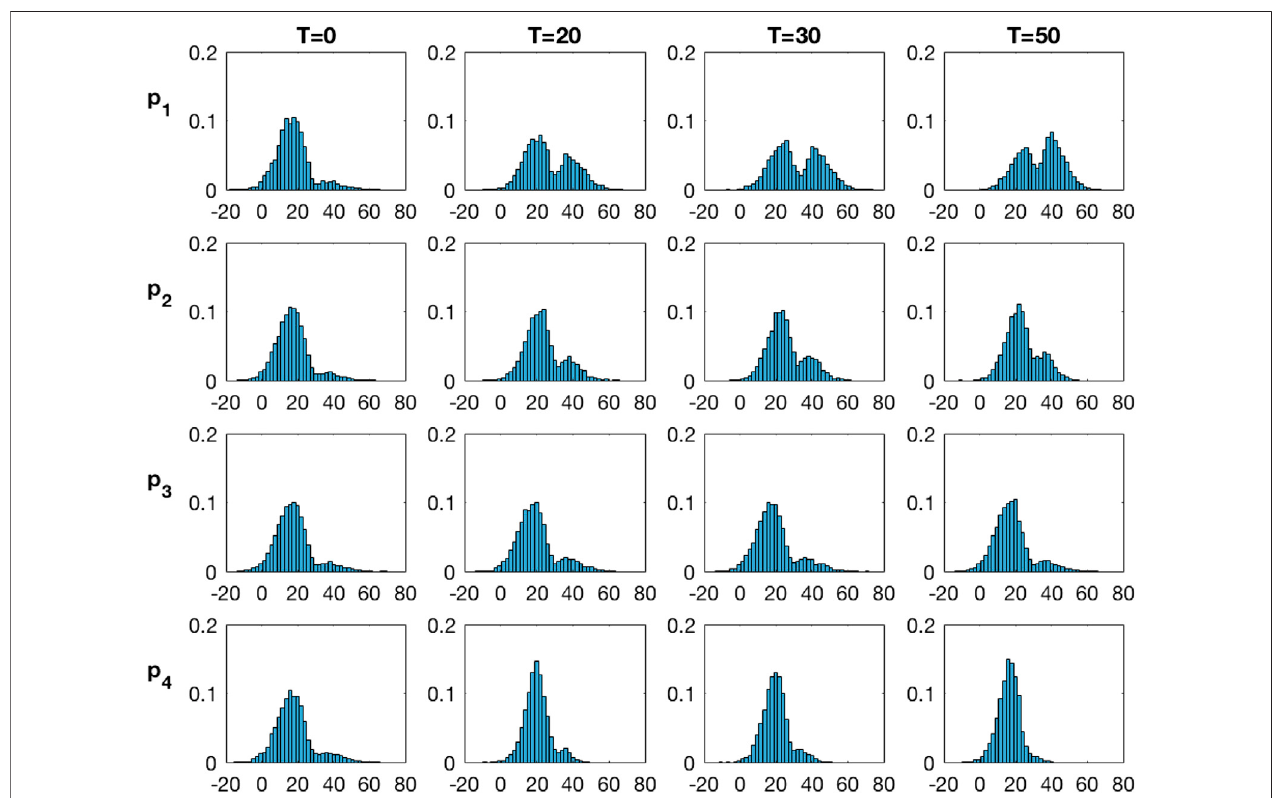
FIGURE 8 | Marginal pdfs at monitoring locations for increasing current time T from the inversion with the selection Kalman model.